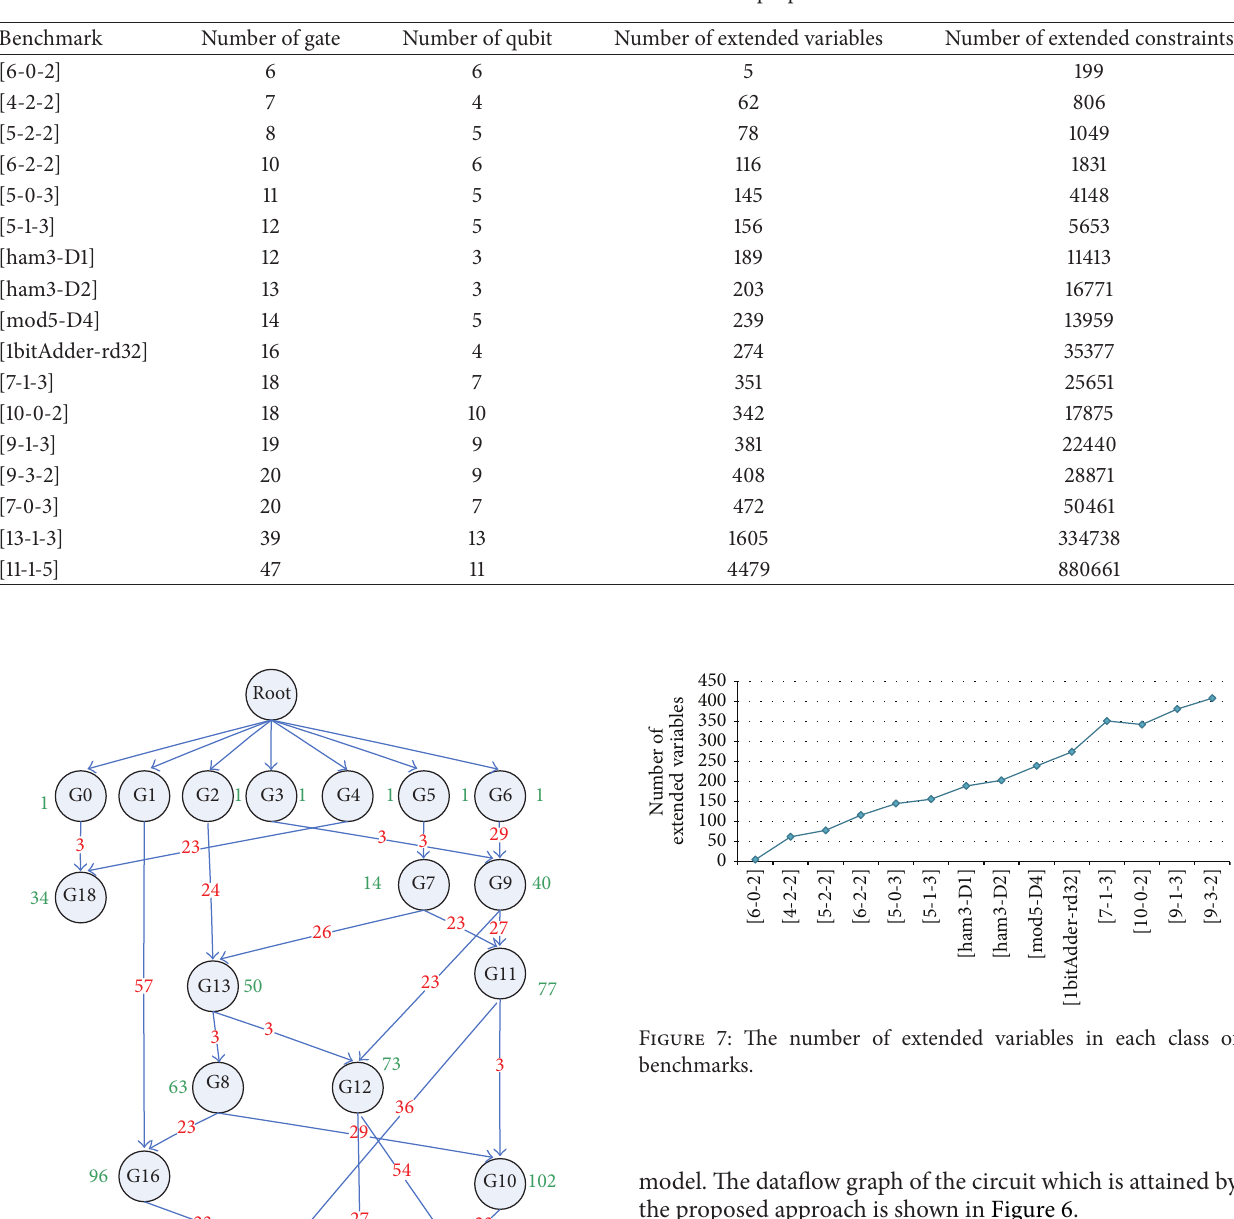
Table 2: Benchmarks used for evaluation of the proposed model.